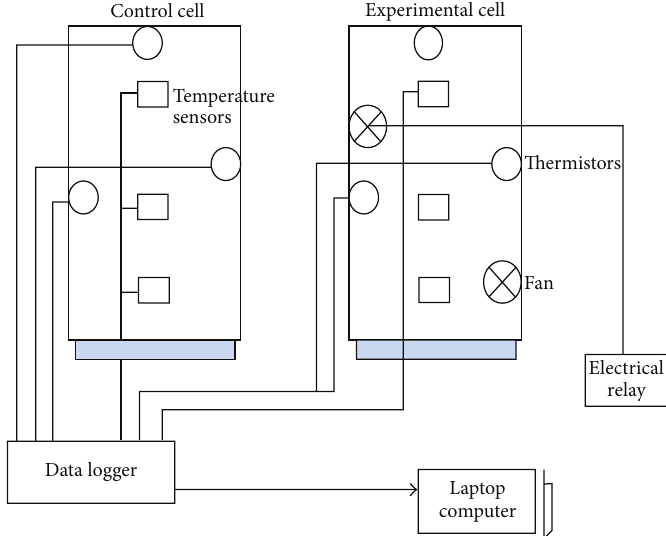
Figure 3: Schematic drawing of the experimental setup.